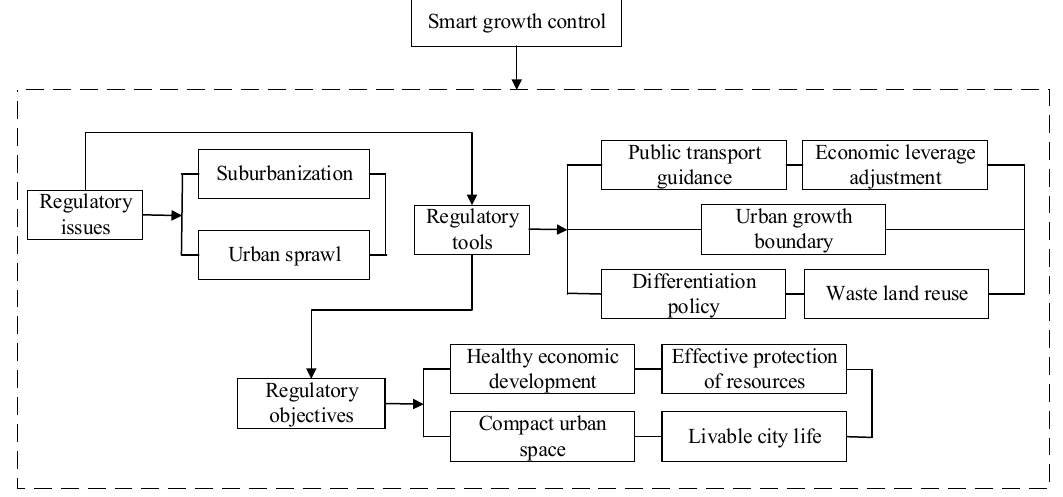
Figure 1. Smart growth regulation mechanism .